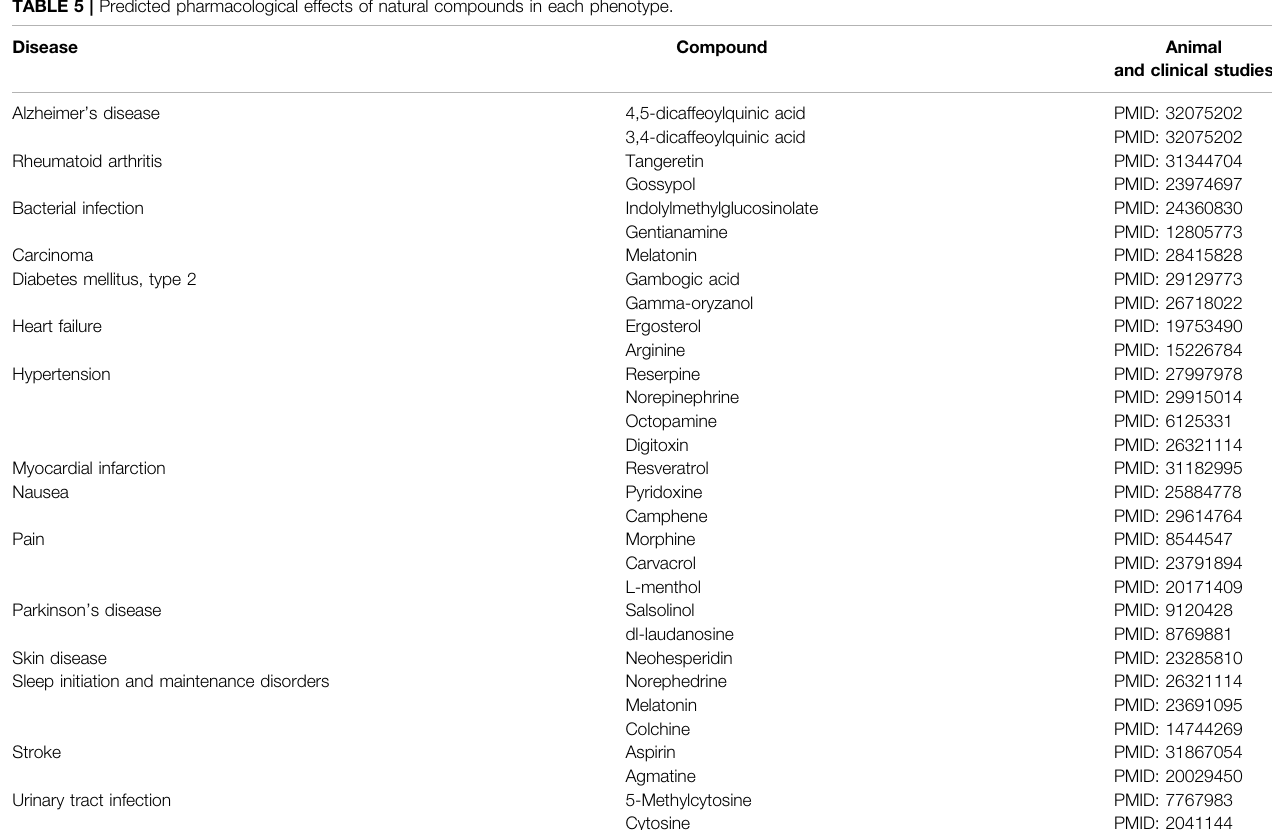
TABLE 5 | Predicted pharmacological effects of natural compounds in each